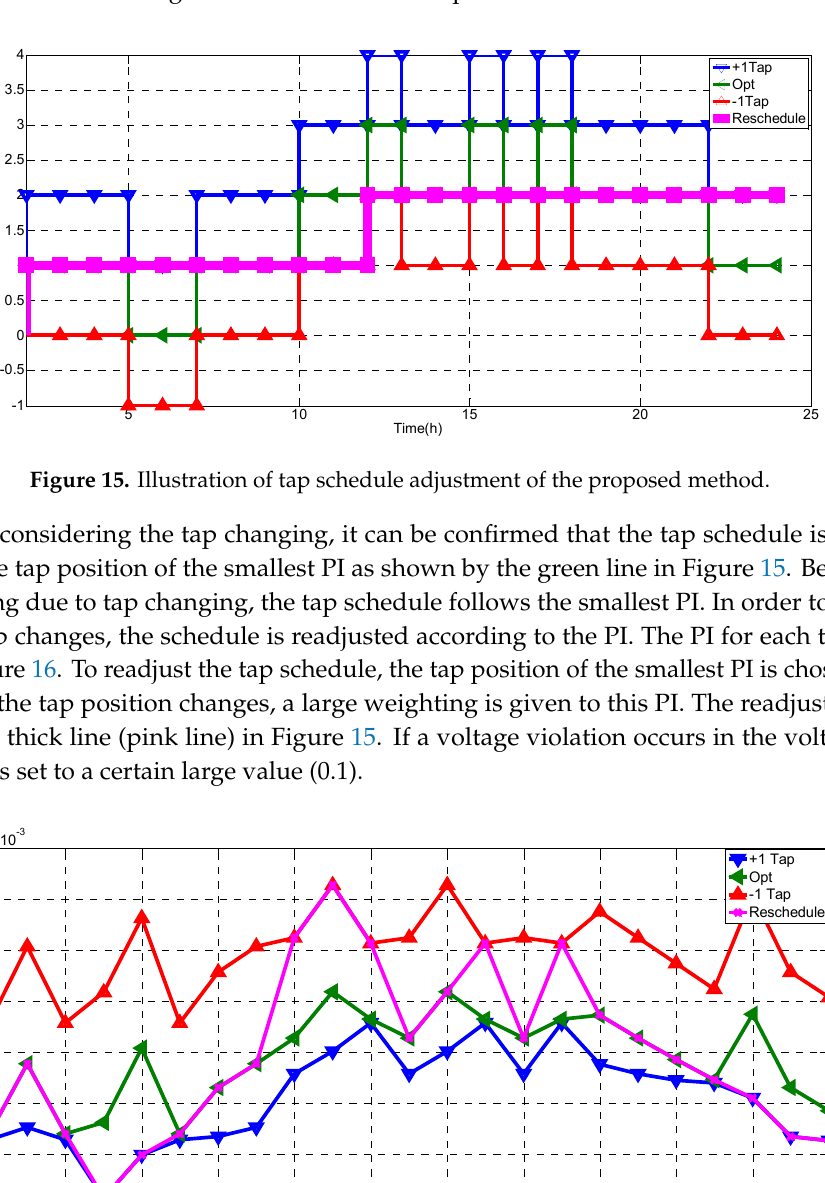
Table 1. Parameters of DGs for case 1.